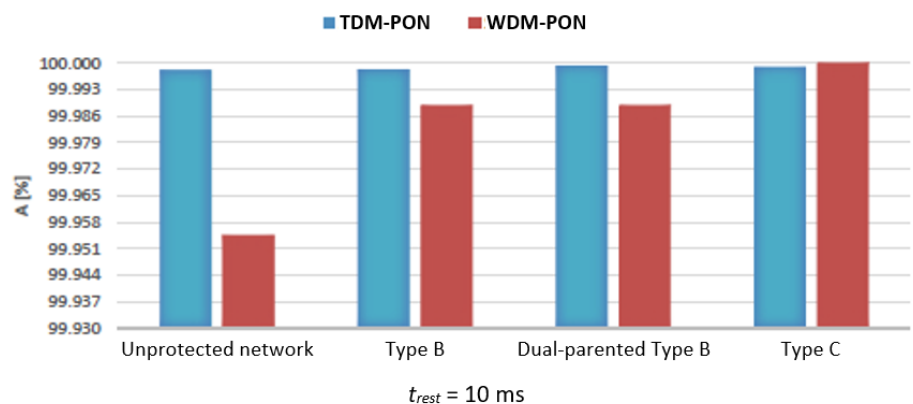
Figure 8. The network availability of TDM-PON and P2MP WDM-PON protection scenarios for the selected restoration time.